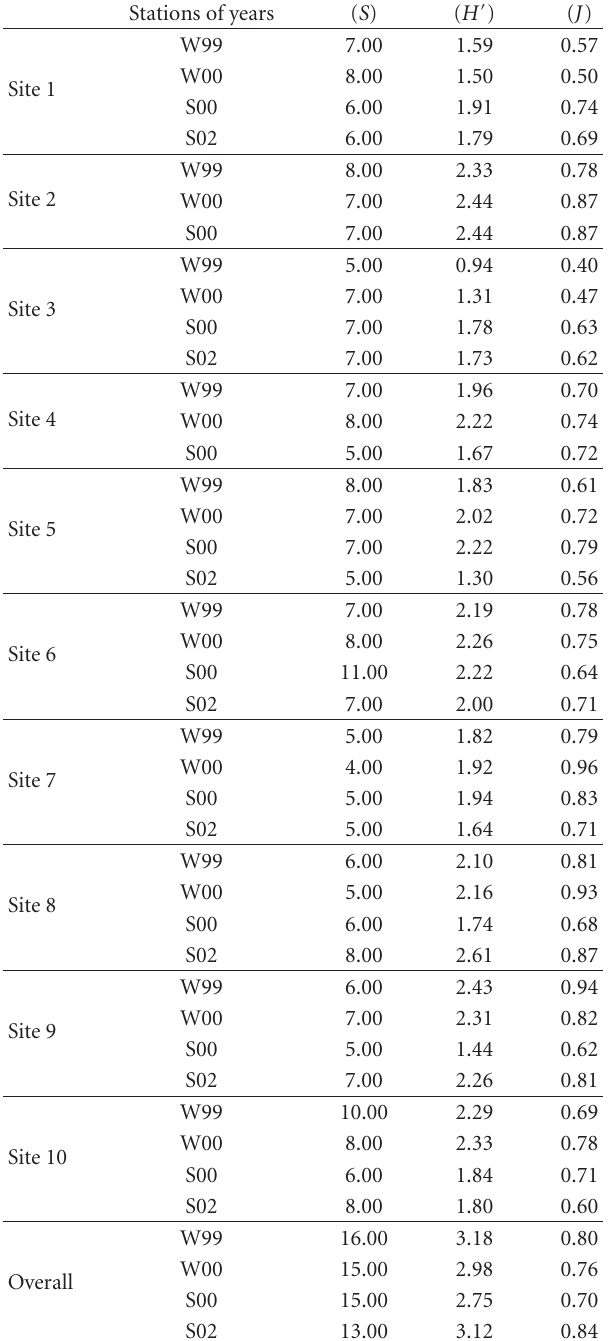
Table 3: R-statistic values for the global ANOSIM and significance of pairwised tests for di ff erences in community structure between reef flat groups of